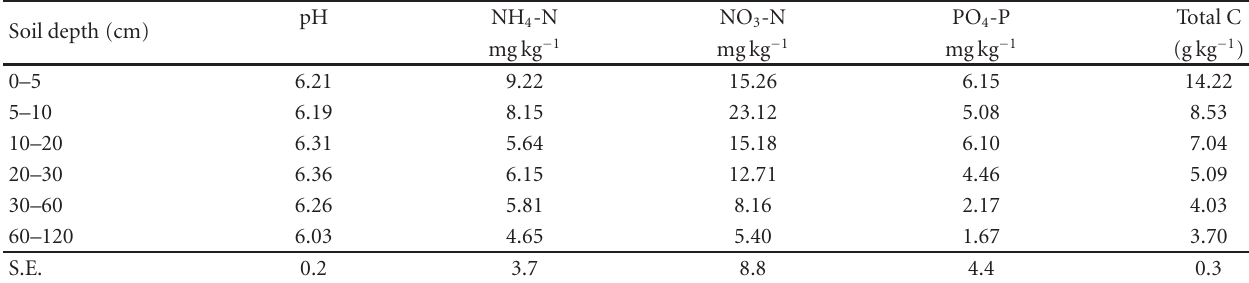
Table 1: Baseline soil properties at the study site prior to establishing treatments, Hazel Green, Alabama.